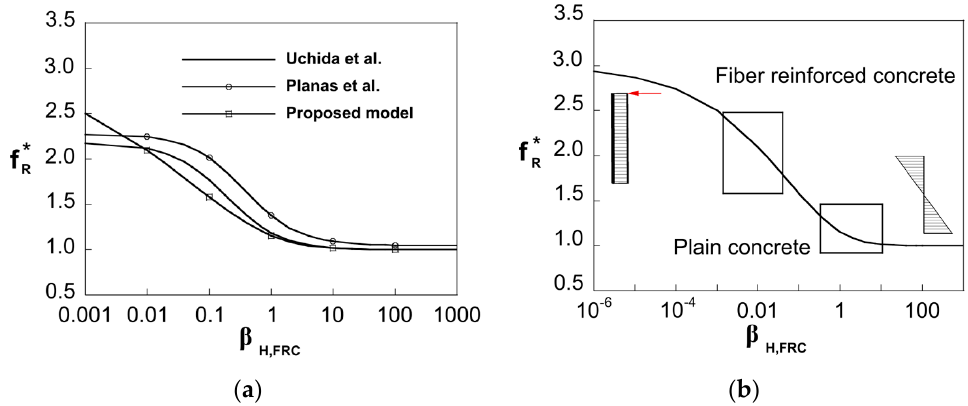
Figure 7. ( a ) Dependency of the flexural strength on the brittleness number, β H,FRC ; ( b ) Asymptotic behavior.